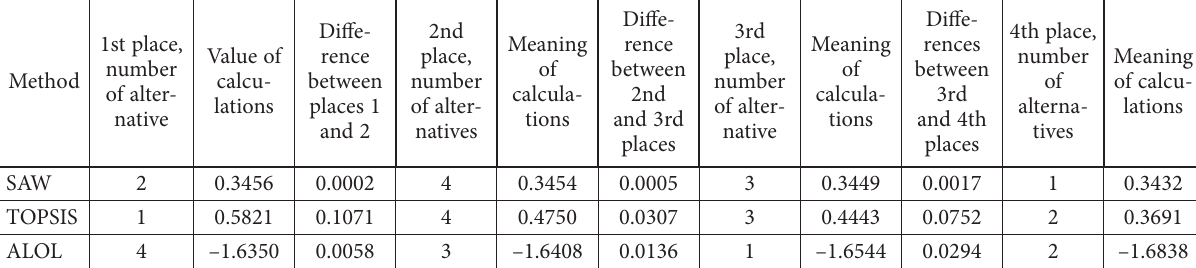
Table 4. Ranking of alternatives. The results show which documents are suitable by different methods